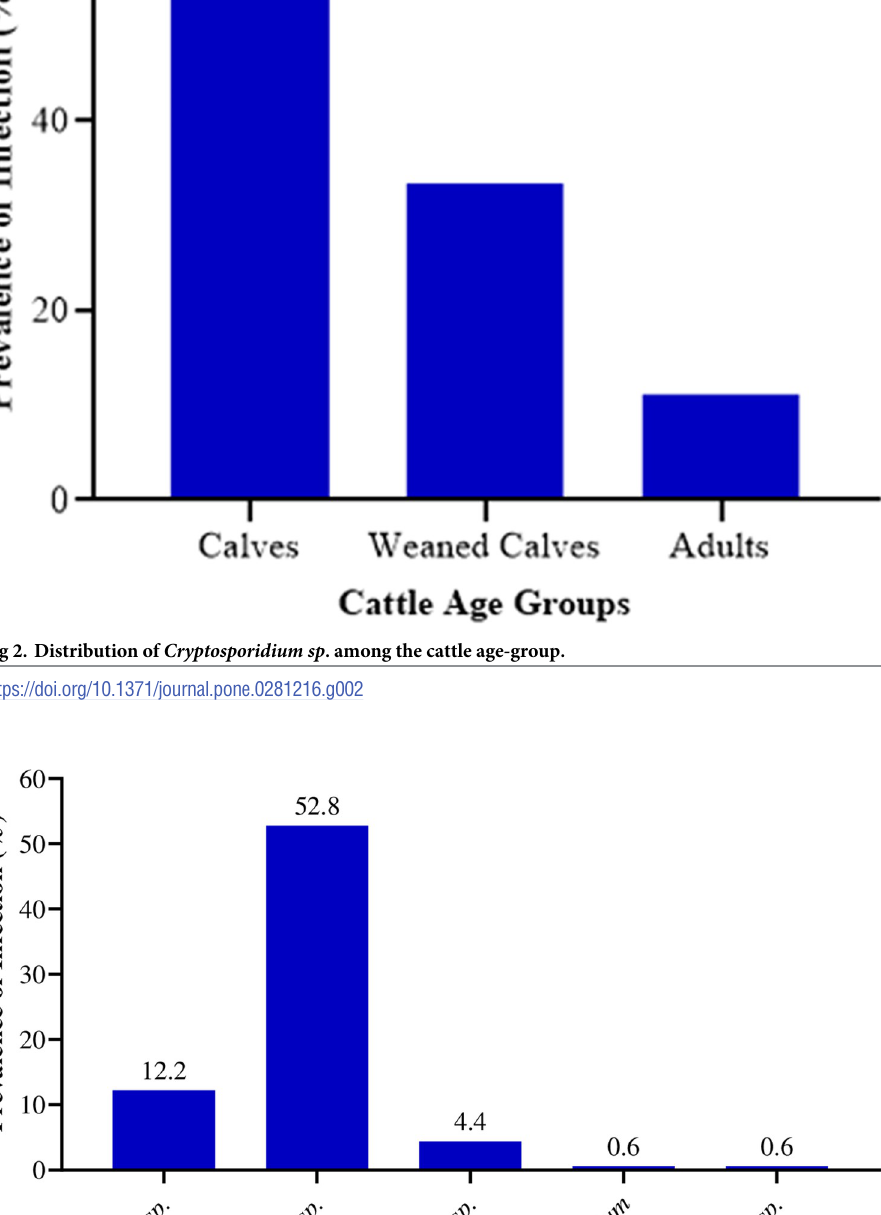
PLOS ONE | https://doi.org/10.1371/journal.pone.0281216 February 24,